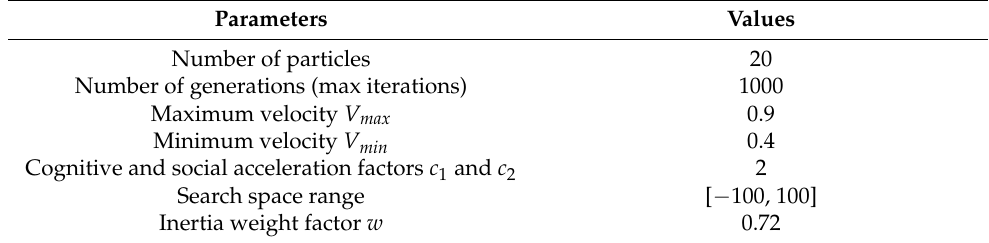
Table 4. Parameters of PSO algorithm.